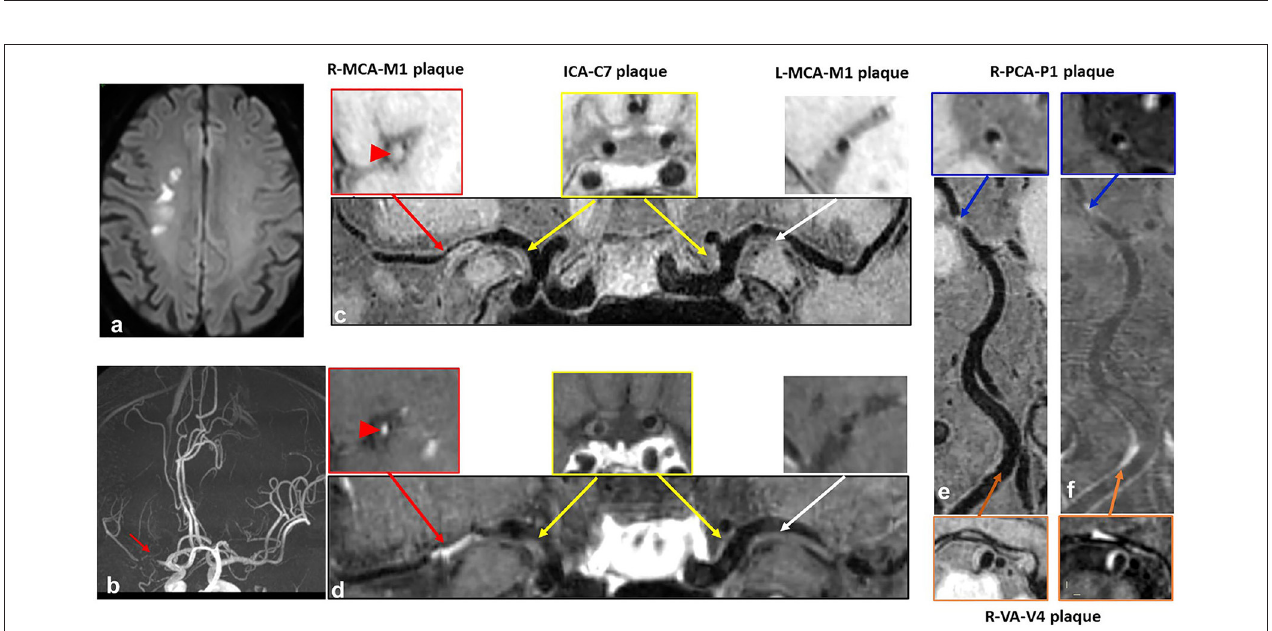
FIGURE 3 | A case with recurrent acute stroke. A 62-year-old male patient presented with recurrent acute stroke. (a) Axial diffusion-weighted imaging detects high-signal-intensity lesions in the right corona radiata. (b) Time-of-flight magnetic resonance angiography image shows severe stenosis on the M1 segment of right middle cerebral artery (MCA) (red arrow) and no obvious stenosis on the left MCA, basilar artery (BA) or posterior cerebral artery (PCA). (c–f) curved planar reconstruction images from pre-contrast and post-contrast whole-brain vessel wall imaging show multiple plaques in the right MCA (red arrow) and left MCA (white arrow), bilateral C7 segment of internal carotid artery (ICA) (yellow arrow), P1 segment of right PCA (blue arrow), and V4 segment of vertebral artery (VA) (orange arrow). Grade 2 enhancement pattern and obvious contrast enhancement are detected in the culprit plaque of the M1 segment of right MCA (red arrowhead).